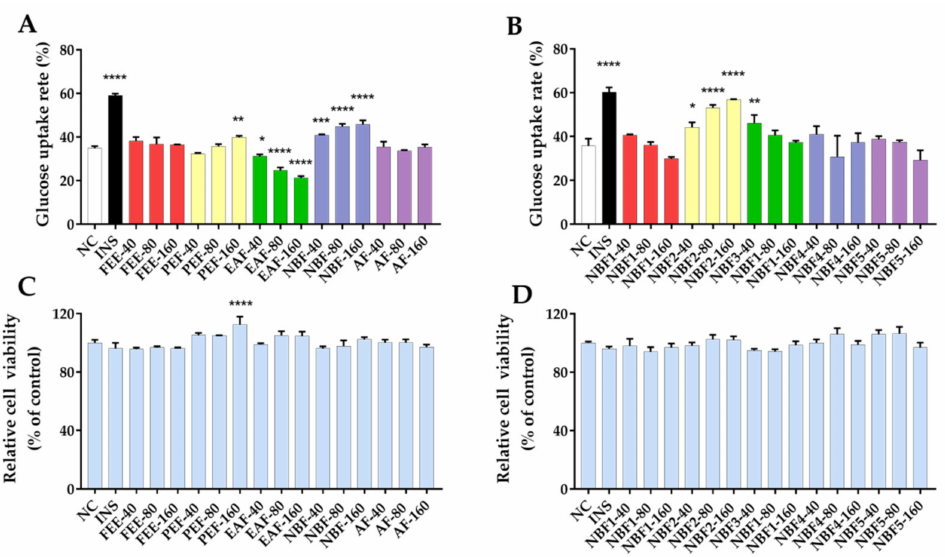
Figure 3. Glucose uptake and relative cell viability in 3T3-L1 adipocytes. ( A ) Glucose uptake rates of F. tikoua extract and fractions (FEE, PEF, EAF, NBF, and AF), ( B ) Glucose uptake rates of five subfractions of NBF (NBF1-NBF5), ( C ) Relative cell viability of F. tikoua extract and fractions, ( D ) Relative cell viability of five subfractions of NBF. NC: negative control; INS: insulin (positive control), 250 ng/mL;